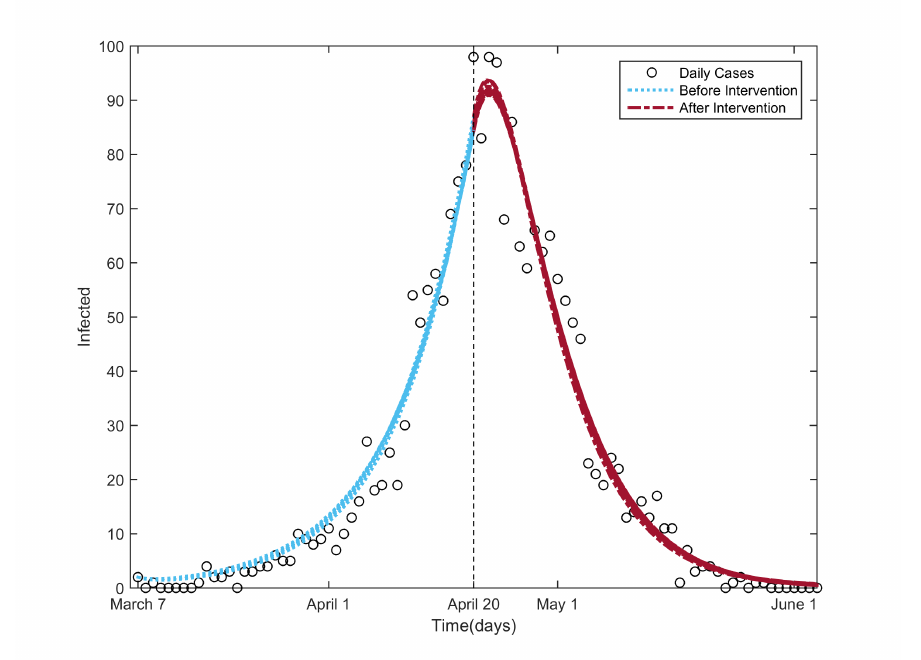
Figure 4. Infectious curves for the fitting procedure of the NBD model to the SARS outbreak in Beijing in 2003. The circle markers denote the daily reported SARS cases; the parts of the curve to the left and right of the vertical line are the infectious curves before and after the control strategies were taken,